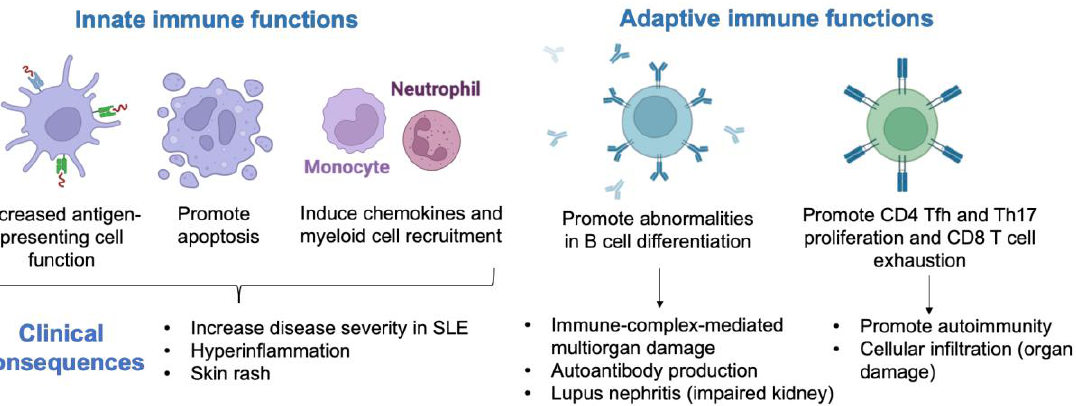
Table 1. Common interferon-α-inducible genes in systemic lupus erythematosus